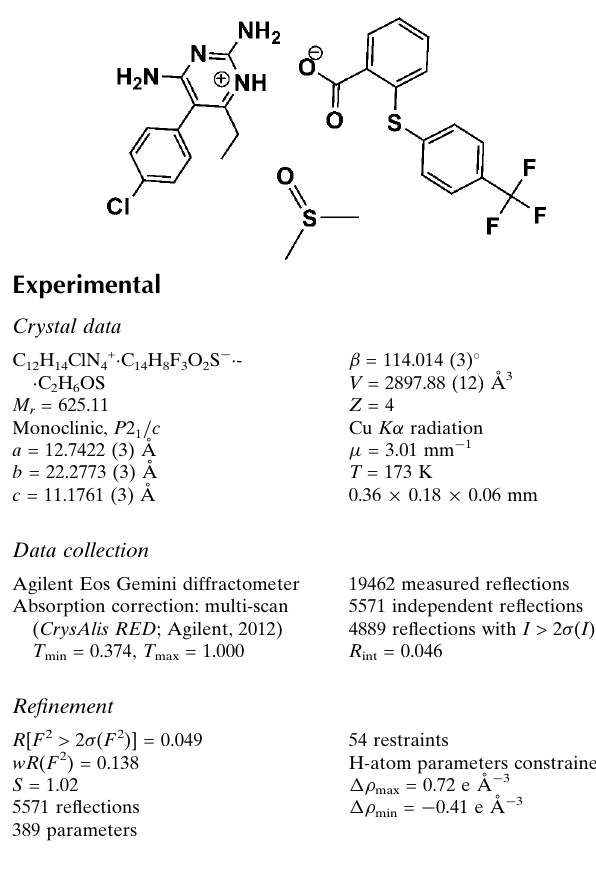
Agilent Eos Gemini diffractometer Absorption correction: multi-scan ( CrysAlis RED ; Agilent, 2012) T min = 0.374, T max = 1.000